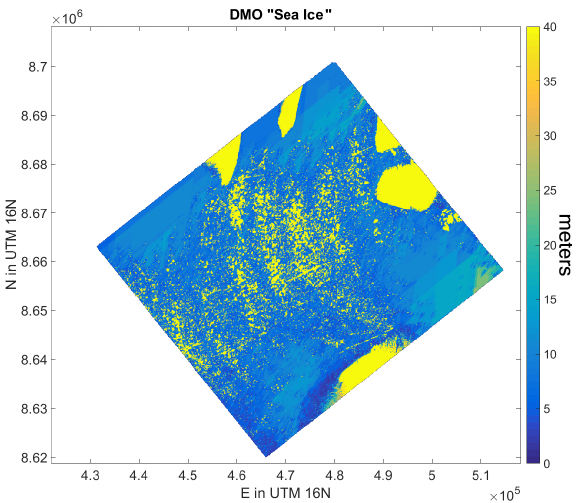
Figure 1: ASTER DMO product over a fast sea ice scene, which should be uniformly flat in the sea area, presents gaps filled with interpolated data and high noise, the data peaks at several hundred meters. The high elevation areas (yellow) at the scene margins represent islands.